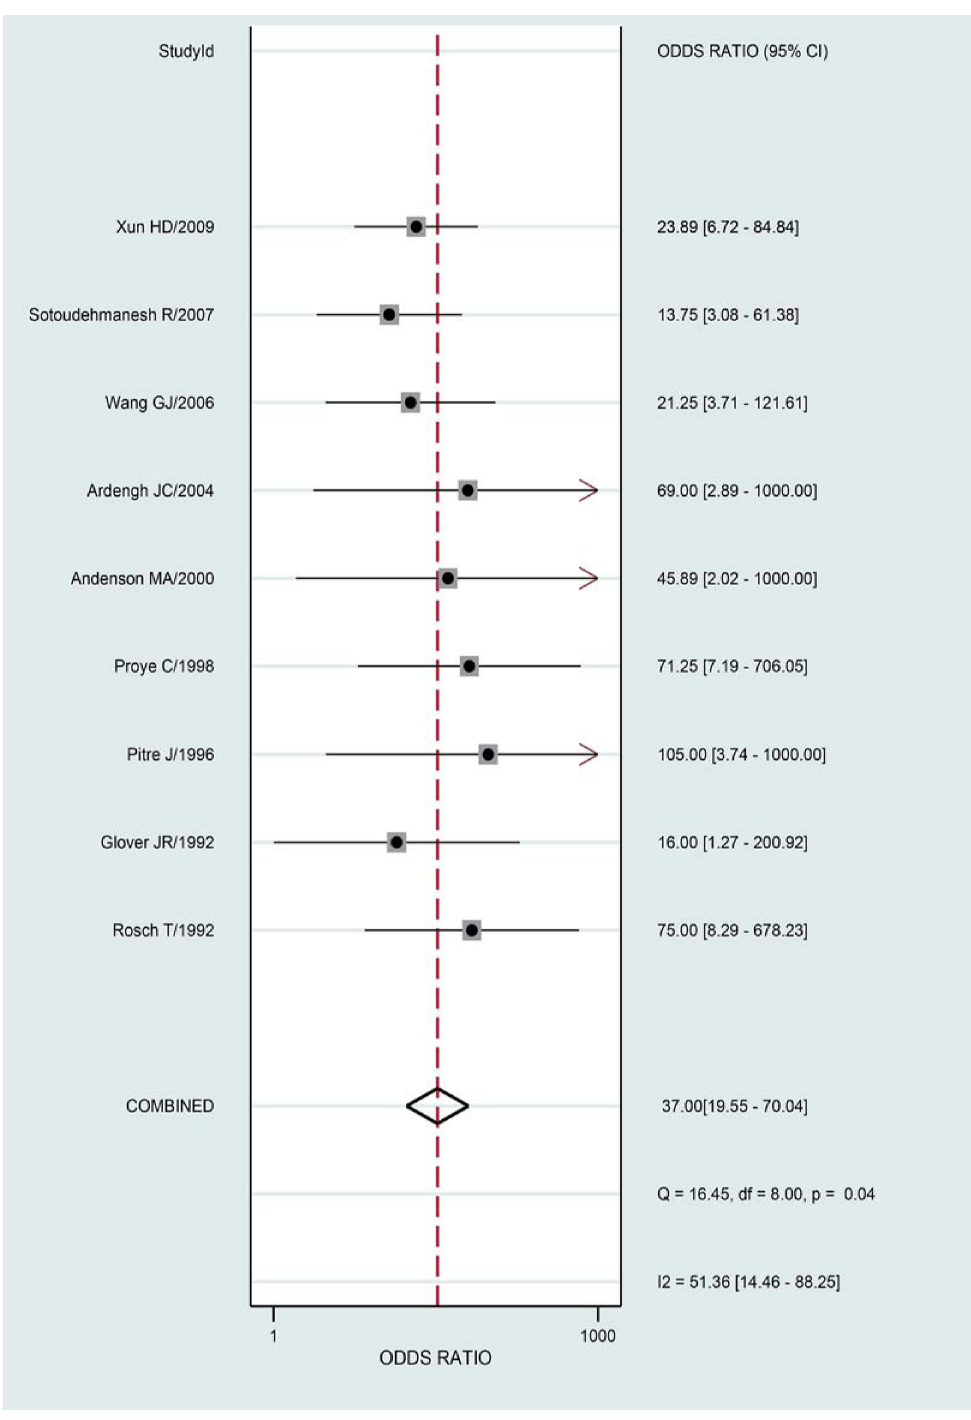
Fig 4. Forest plot for